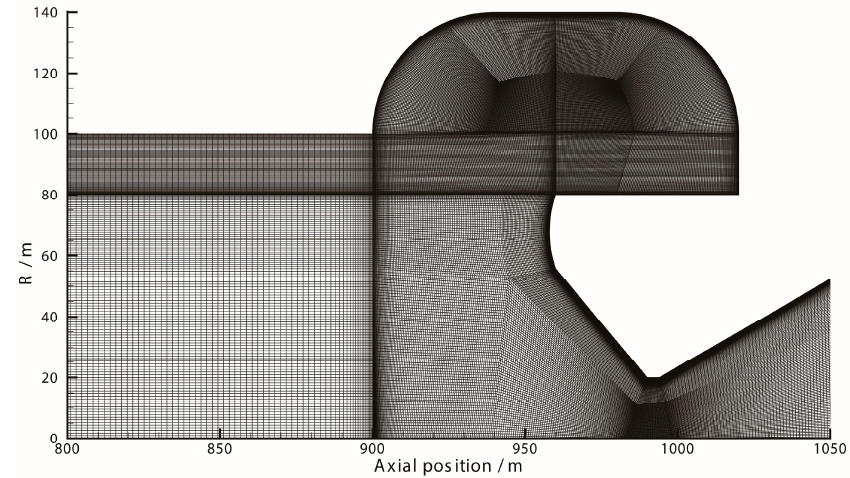
Figure 3. Typical grids at submerged nozzle in the flow ‐ field simulation.